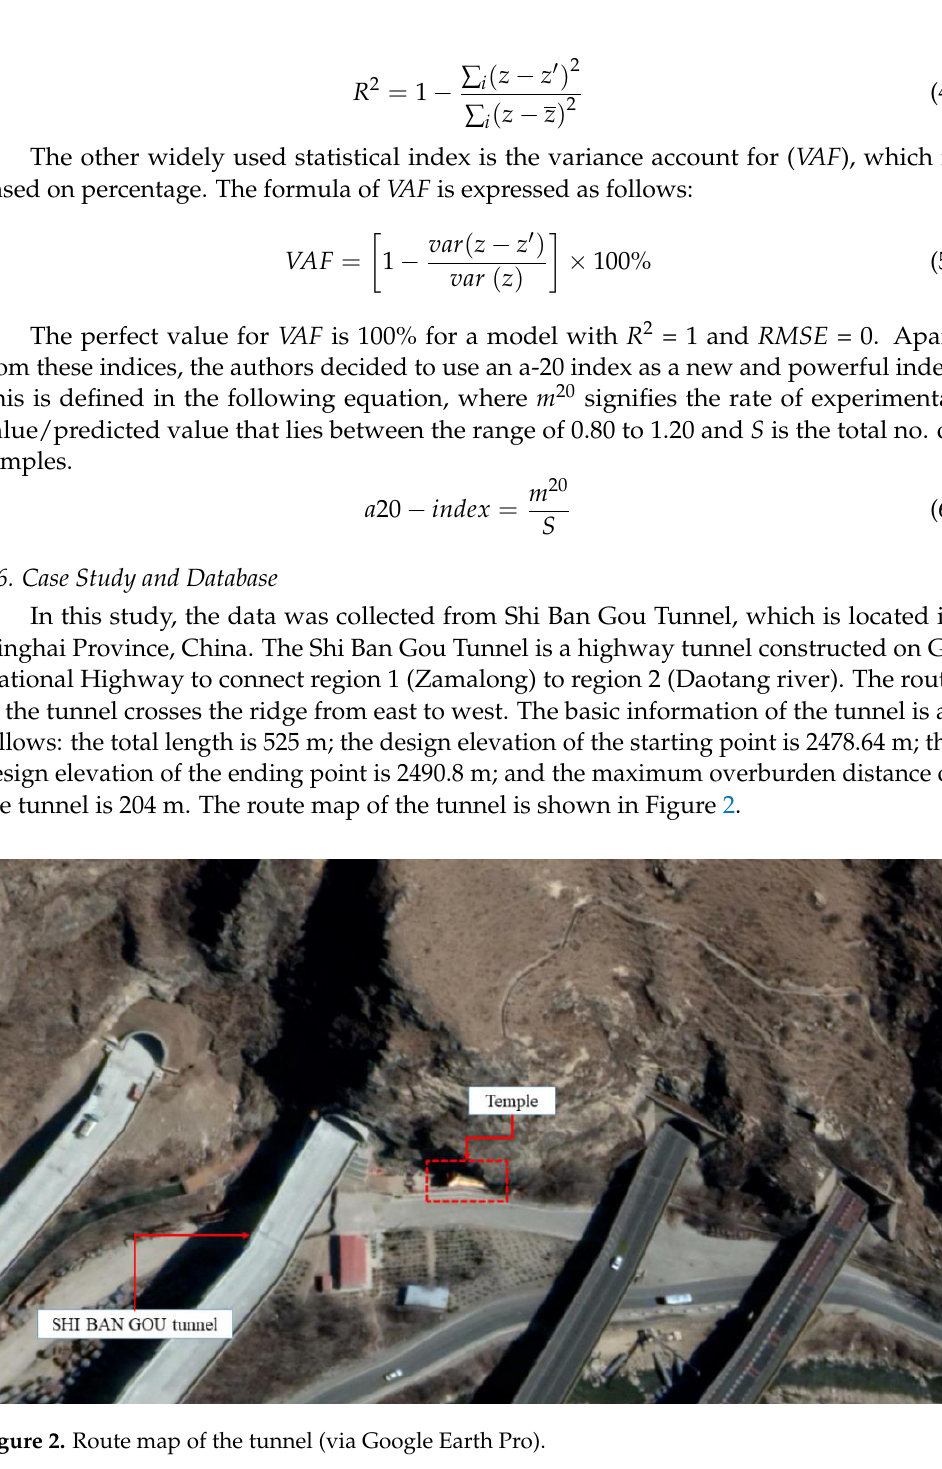
Figure 3. Positions of the tunnel and temple. Figure 4. A measurement and monitoring point of PPV values induced by blasting. To establish a database to forecast PPV values, the results of the Shi Ban Gou Tunnel during blasting operations were considered and used. Three hundred and one blasting